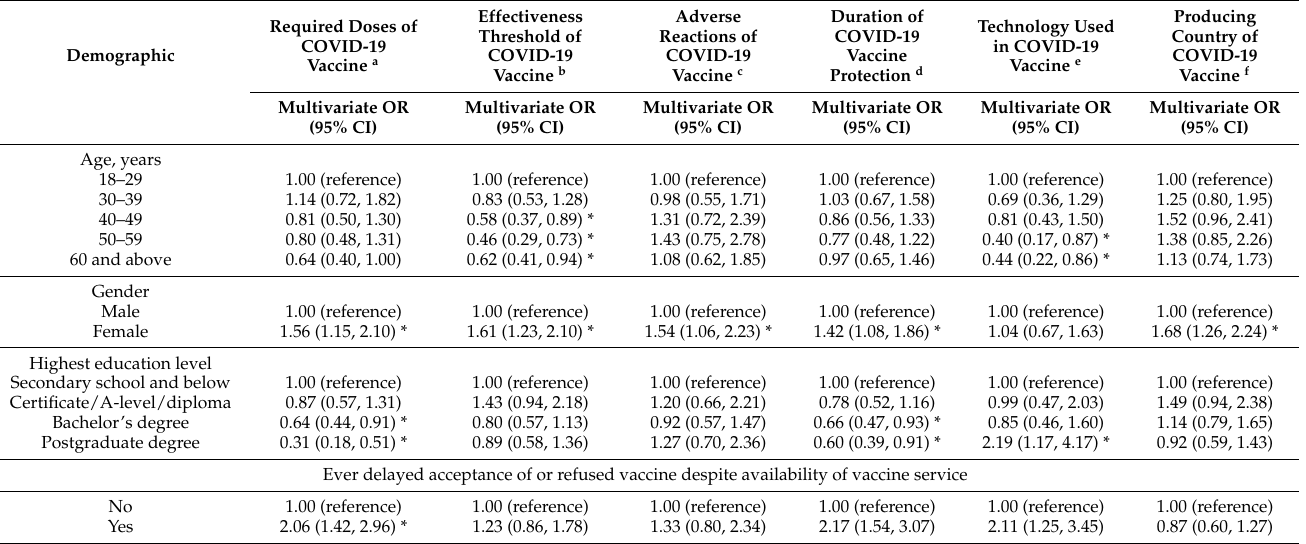
Table 4. Vaccine characteristics influencing vaccination acceptance by demographics of the partici- pants in